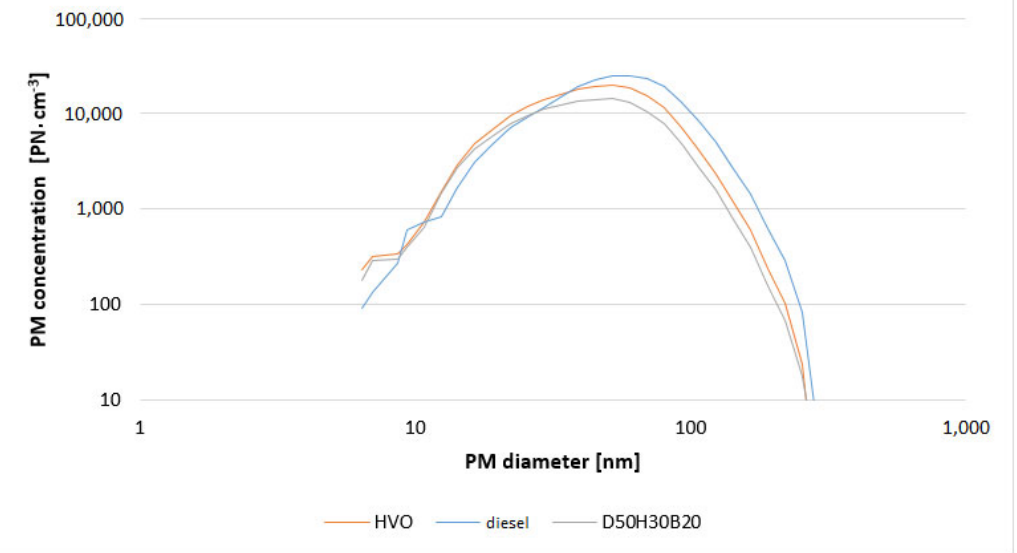
Figure 6. PM production at steady-state speed 50 km · h − 1 .